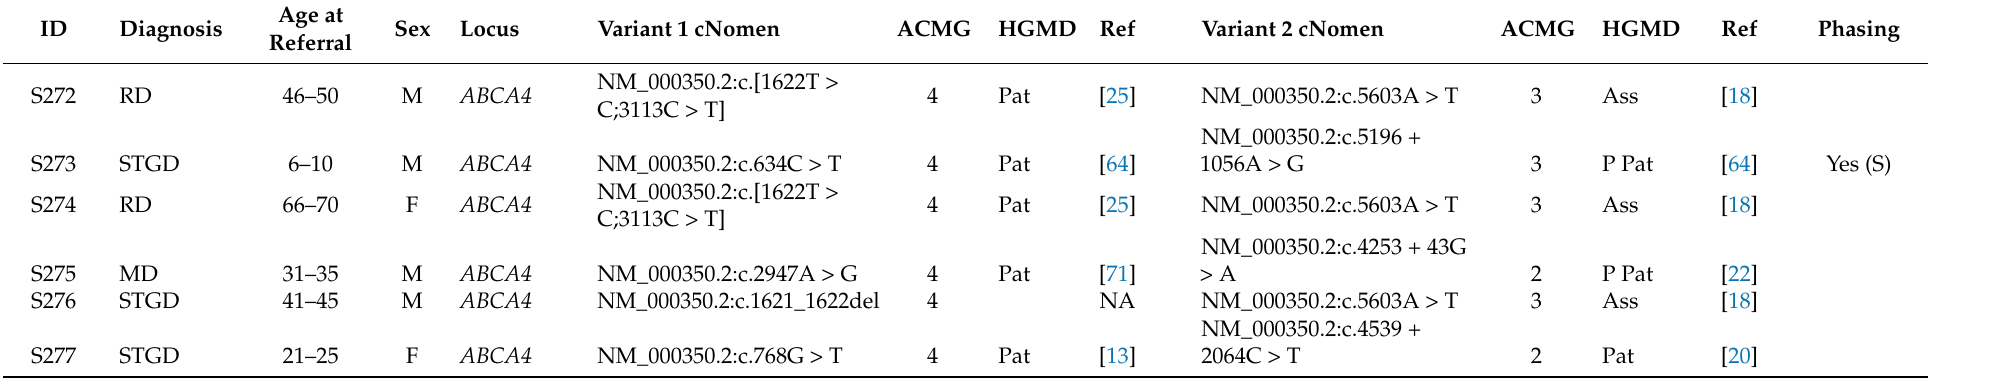
Table A3. Missing heritability cohort findings. Abbreviations: ID, index patient ID; cNomen, Human Genome Variation Society (HGVS) cDNA-level nucleotide change nomenclature; HGMD, Human Gene Mutation Database; ACMG, American College of Medical Genetics and Genomics guidelines; F, female; M, male; Pat, pathogenic; P Pat, possibly pathogenic; Ass, association; Ref, reference; NA, not applicable; S,